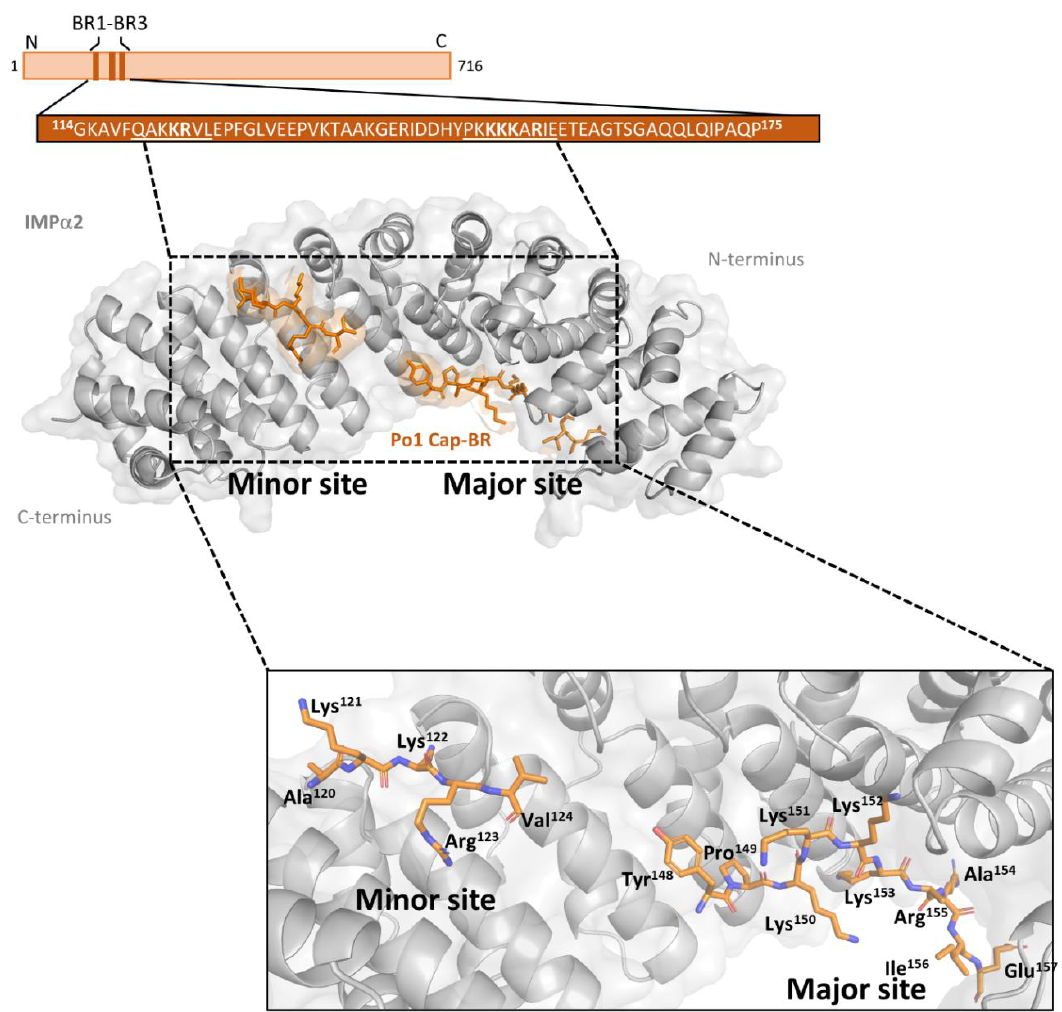
Figure 3. Crystal structure of AAV Po1 Cap-BR in complex with IMPα2. Schematic overview of the AAV Po1 Cap protein, structure of the AAV Po1 Cap-BR (orange sticks), and IMPα2 (grey ribbons/transparent surface) complex resolved to 2.6 Å resolution. The sequence of AAV Po1 Cap-BR bound to IMPα2 is detailed in the box (basic regions determined by sequence alignment are underlined, and residues determined to participate in the interaction are in bold). This structure has been deposited to the PDB and given the code: 8FK3.